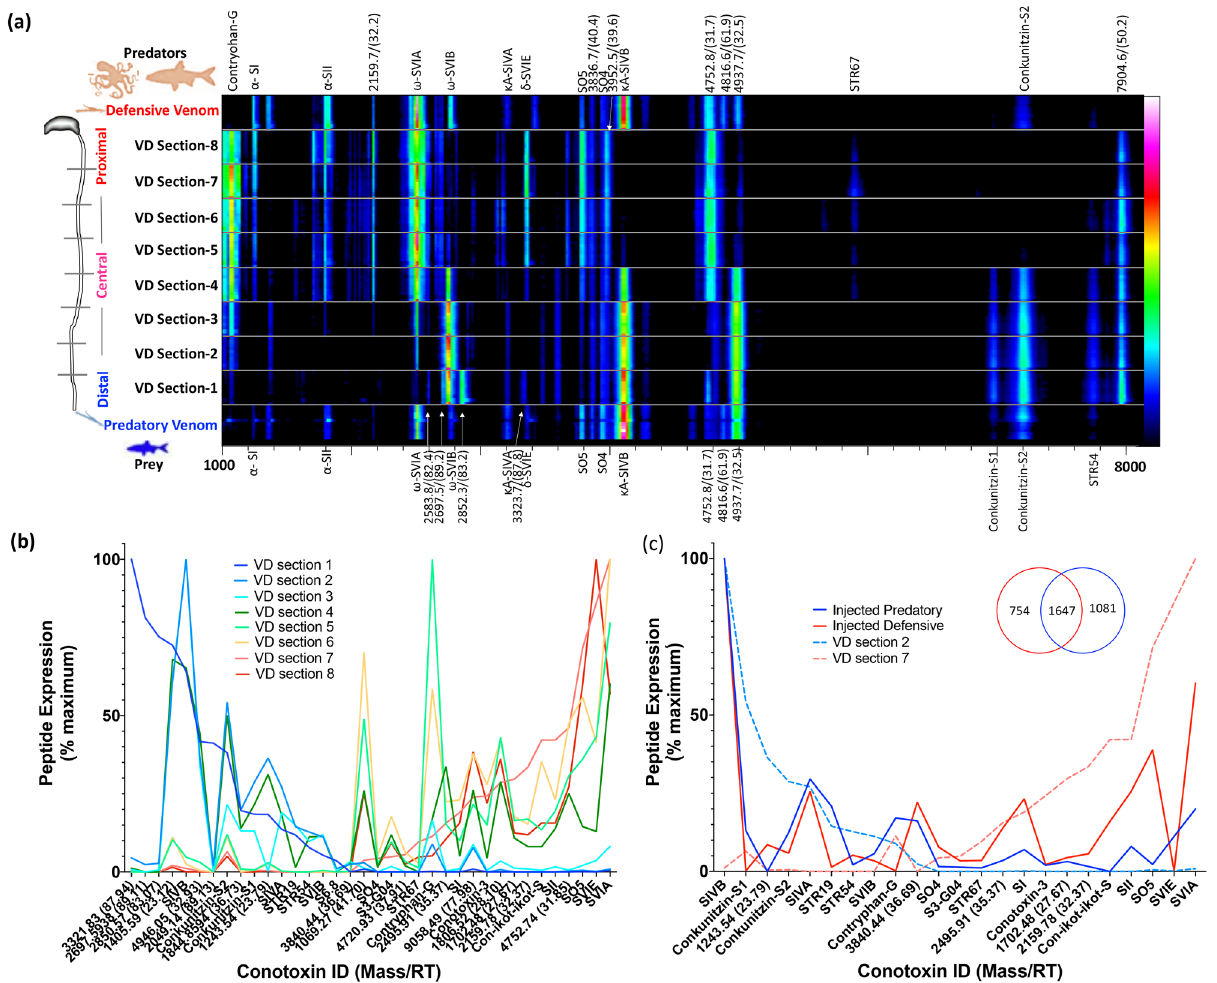
Figure 5. Visualisation of the venom distribution pattern across eight venom duct sections and their correlation to the injected predatory and defensive venoms obtained from the same specimen of C. striatus (specimen D). (a) MALDI spot imaging showing the alignment of the injected predatory and defensive venoms with extracted venoms of eight venom duct sections of the injected and extracted venoms. (b) Quantitative analysis of the major peptides found in the LC/MS profiles of the dissected venoms (venoms extracted from 8 duct segments). Both the retention time and the mass was considered when identifying the peptides across the duct sections and injected venoms. Peptides are ranked to the expression levels (relative to the maximum intensity of each sample) of section 1 (left) and 7 (right). (c) Mass profile comparisons were made between the LC/MS data obtained by injecting similar amount (1 μl) of the injected predatory and defensive venoms in comparison the distal duct section 2 and proximal duct section 7. Peptides are ranked by expression level (relative to the maximum intensity of each sample) of section 2 (left) and 7 (right). The inset Venn diagram shows the unique and the shared masses in each venom. Reconstructed LC/MS chromatograms were used to analyse the mass profiles and their expression levels. Figure 5b,c are also shown in heat map versions in supplementary Figure